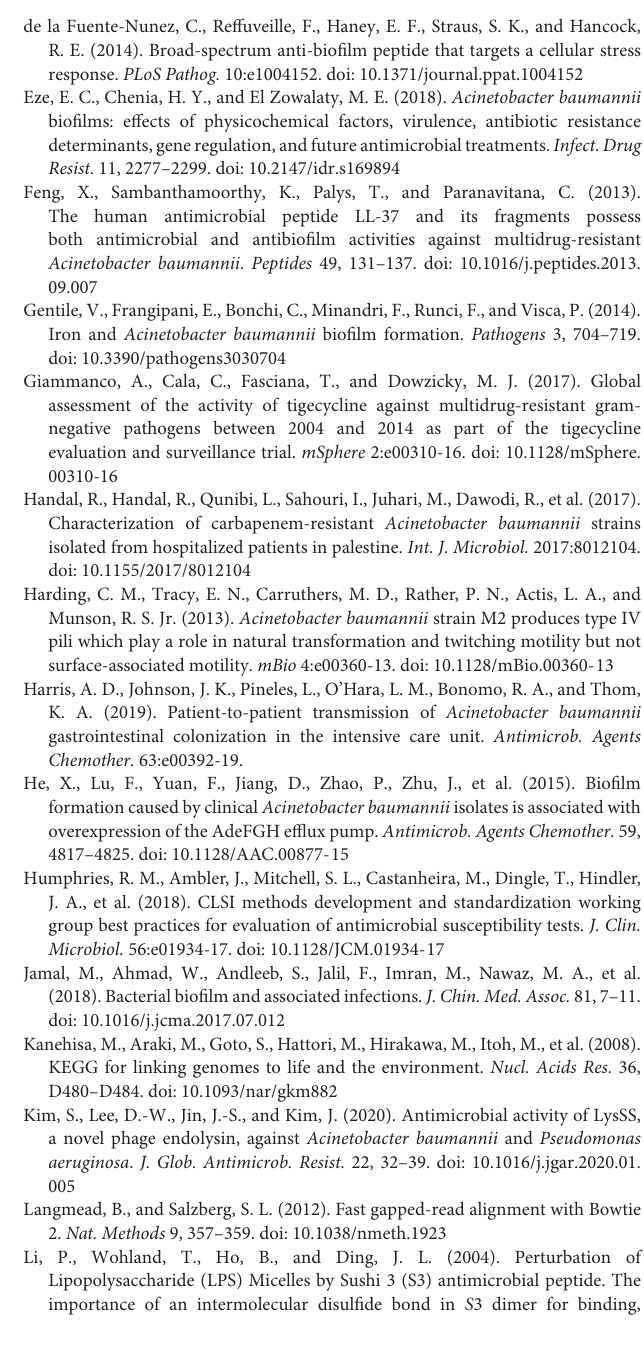
FIGURE S1 | Images of twitching motility after treated with Cec4. From left to right (A–E) , the concentration of Cec4 is 0, 2, 4, 8, 16 µ g/ml. FIGURE S2 | Images of surface-associated motility after treated with Cec4. From left to right (A–E) , the concentration of Cec4 is 0, 2, 4, 8, 16 µ g/ml. TABLE S1 | Oligonucleotide primers used in this study. TABLE S2 | The MICs, MBIC, MBEC, sample source and drug susceptibility of 200 CRAB